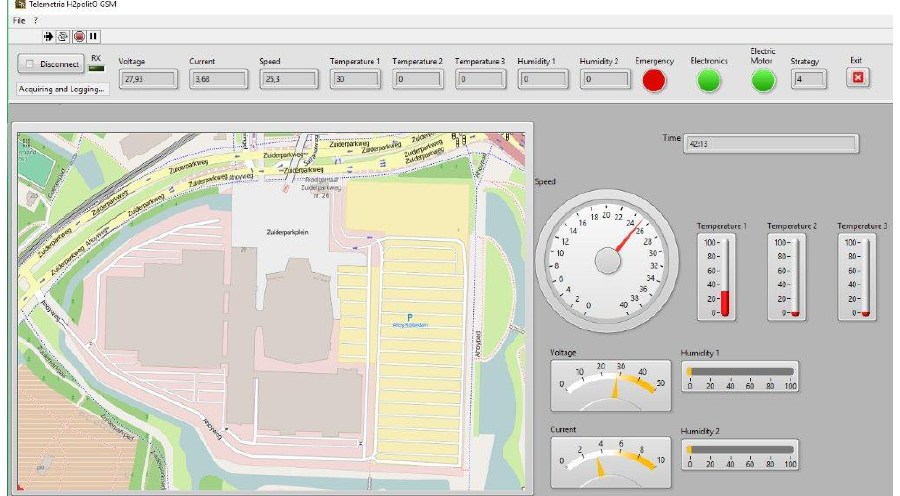
Figure 8. Example of telemetry